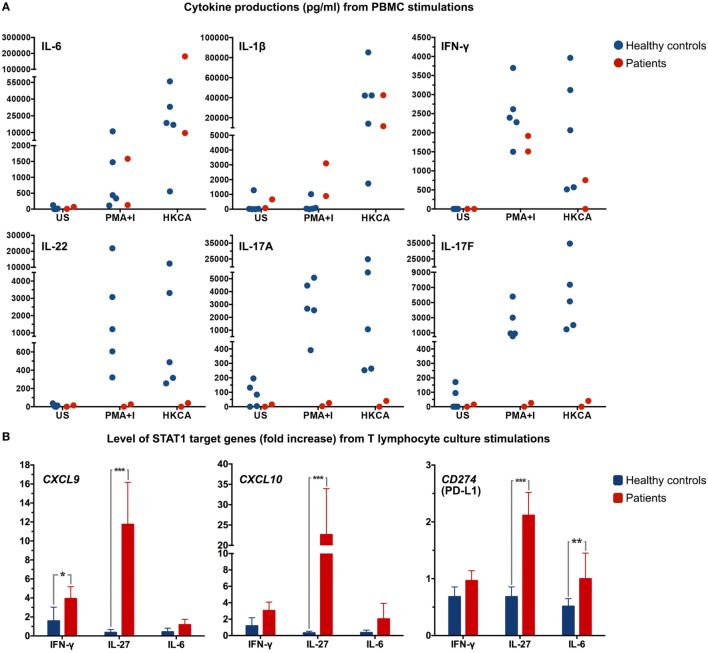
(A) Dot plots depicting cytokine production in supernatant from peripheral blood mononuclear cells (PBMC) from both patients and healthy controls (n = 5) after stimulation of 106 PBMC with PMA-ionomycin (PMA+I) or heat-killed C. albicans (HKCA). Every symbol indicates an individual. US, unstimulated. (B) T lymphocyte cultures were stimulated for 24 h with IFN-γ, IL-27, or IL-6 and mRNA expression levels of CXCL9, CXCL10, and CD274 (PD-L1) were determined by real-time quantitative Taqman PCR. Data were normalized to the housekeeping gene, ABL. *P < 0.05, **P < 0.01, ***P < 0.001 when compared with healthy controls.